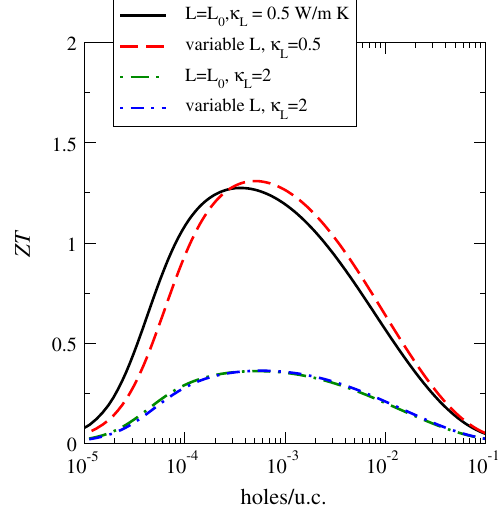
FIG. 7. The calculated figure-of-merit ZT for Bi 2 Se 3 at 300 K, for the indicated 300 K values of the lattice thermal conductivity, and with the free-electron Lorenz number of 2 : 45 (cid:2) 10 (cid:3) 8 ð V = K Þ 2 as well as that calculated from the first principles approach. Note that one hole per unit cell is 7 : 08 (cid:2) 10 21 = cm 3 .